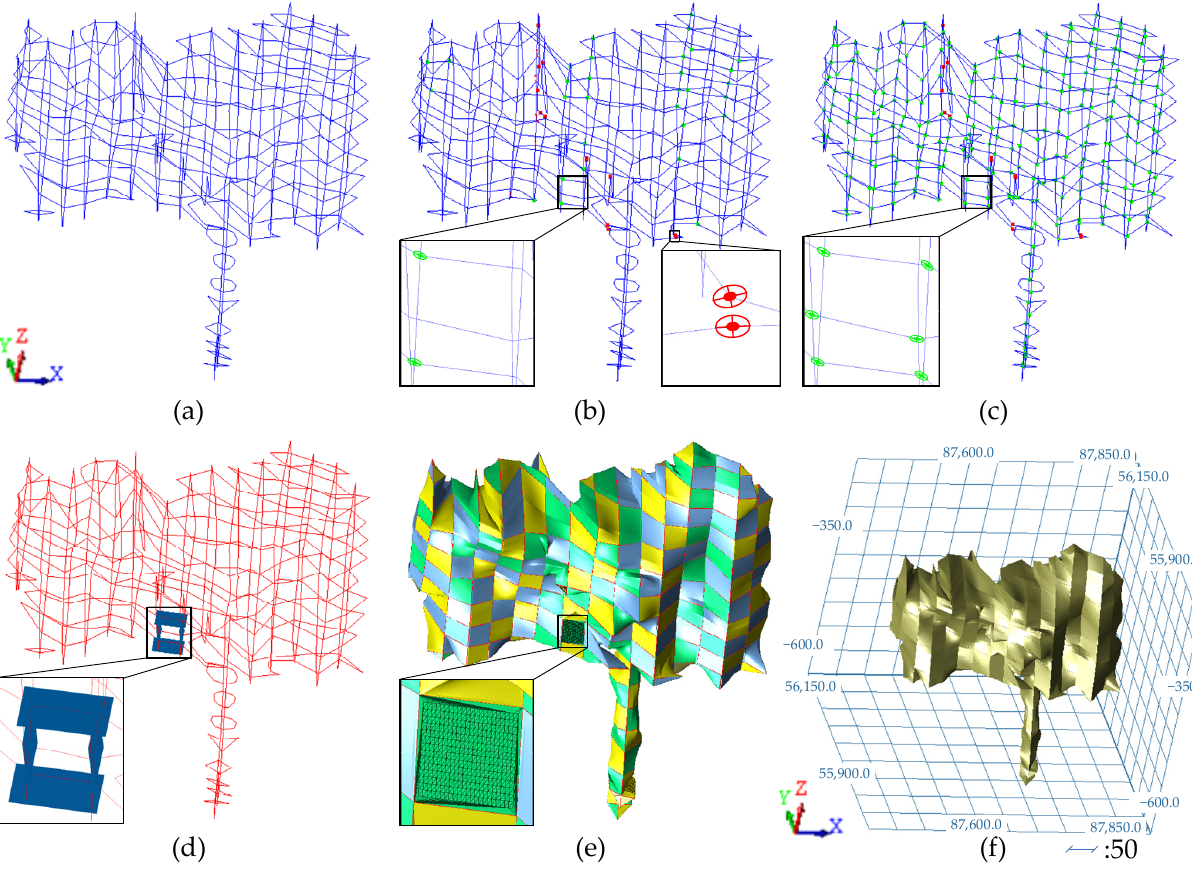
Figure 15. Experimental results of the fourth set of contour polylines: ( a ) the original contour polylines; ( b ) original intersections; ( c ) processed intersections; ( d ) closed-loop division; ( e ) single closed-loop modeling; ( f ) sub-mesh combination.